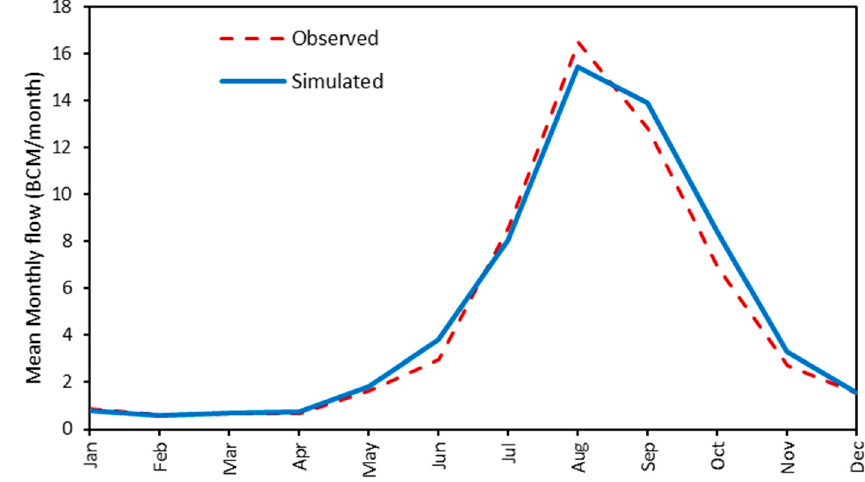
Figure 10. The mean monthly flow at Diem station for the validated period.